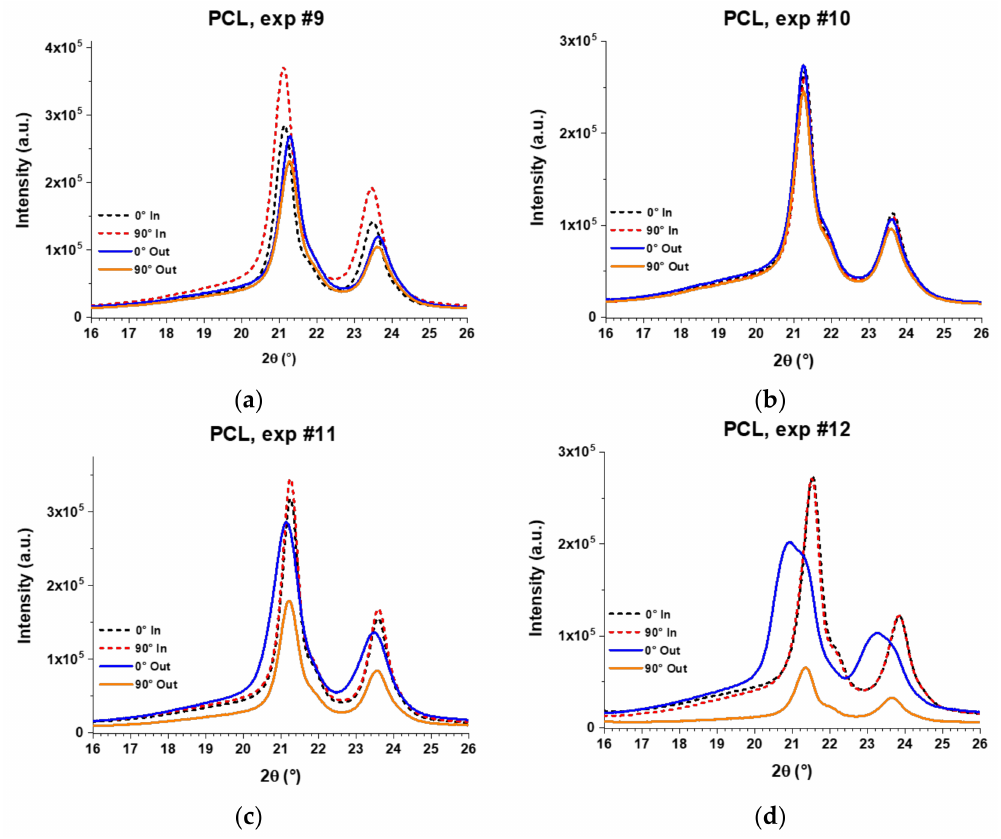
Figure 17. XRD patterns of PCL sheets formed by SPIF through experiments ( a ) #9; ( b ) #10; ( c ) #11; and ( d ) #12. The XRD analysis was carried out separately for the inner surface (in contact with the forming tool) and the outer surface (not in contact with the forming tool) according to the experimental setup described in Figure